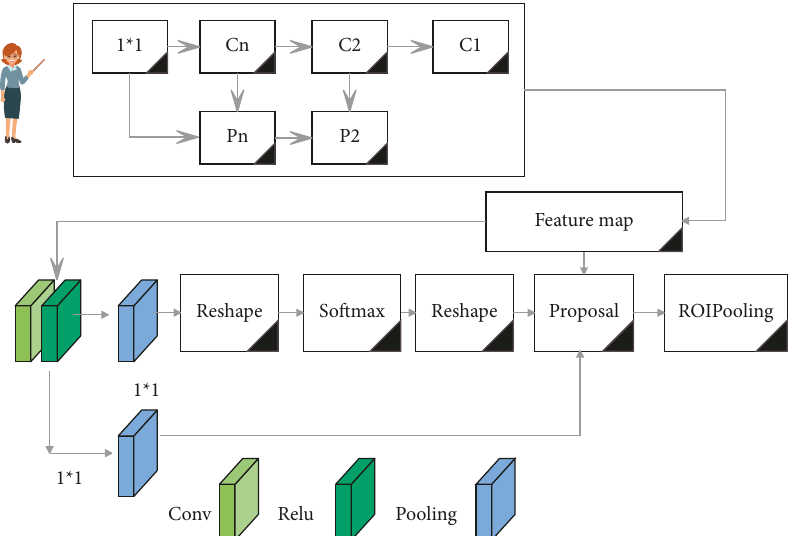
Figure 6: Schematic diagram of algorithm based on multiscale feature map